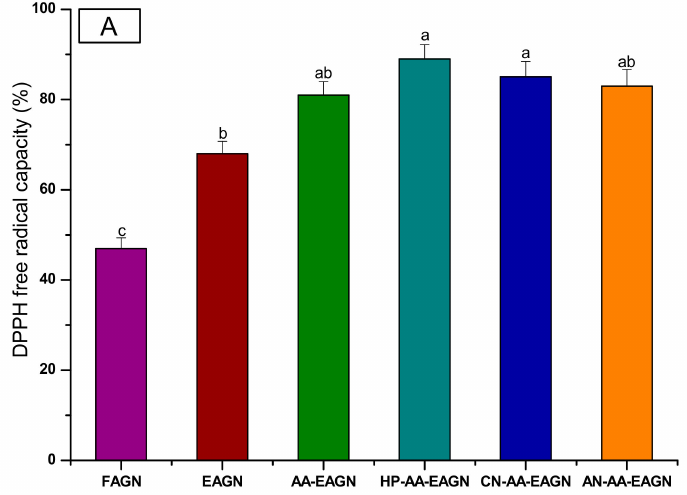
Figure 6. The content of decursin (D) and decursinol angelate (DA) of the AGNC formulation. Values marked by di ff erent letters in each column are significantly di ff erent in the t -test ( p < 0.05).